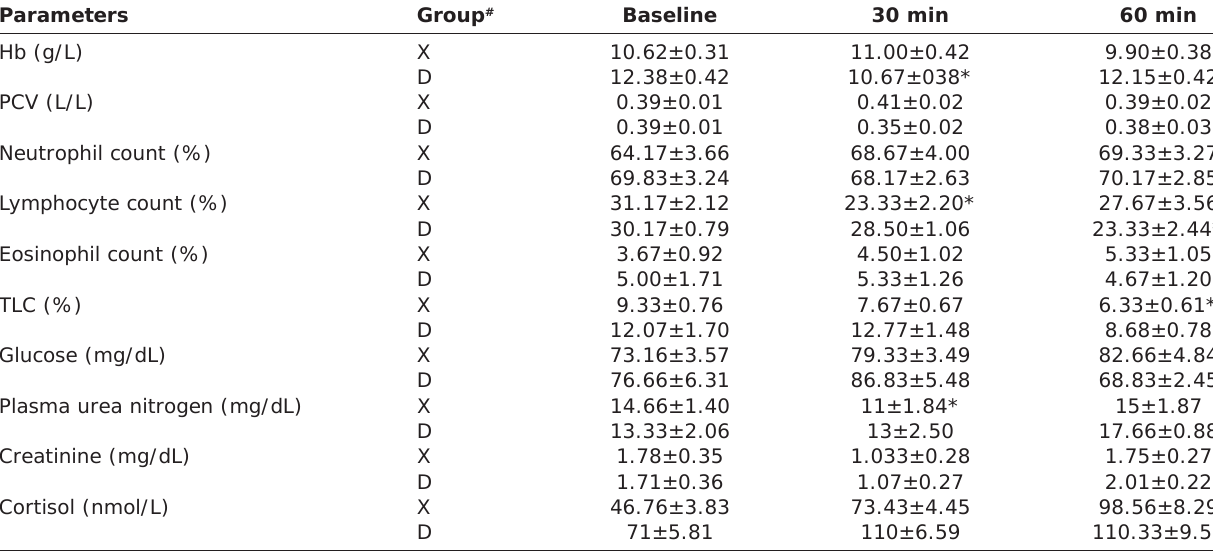
Table-1: Effects of intravenous administration of xylazine/dexmedetomidine along with propofol on haematological and biochemical parameters in canine patients (mean±SE).